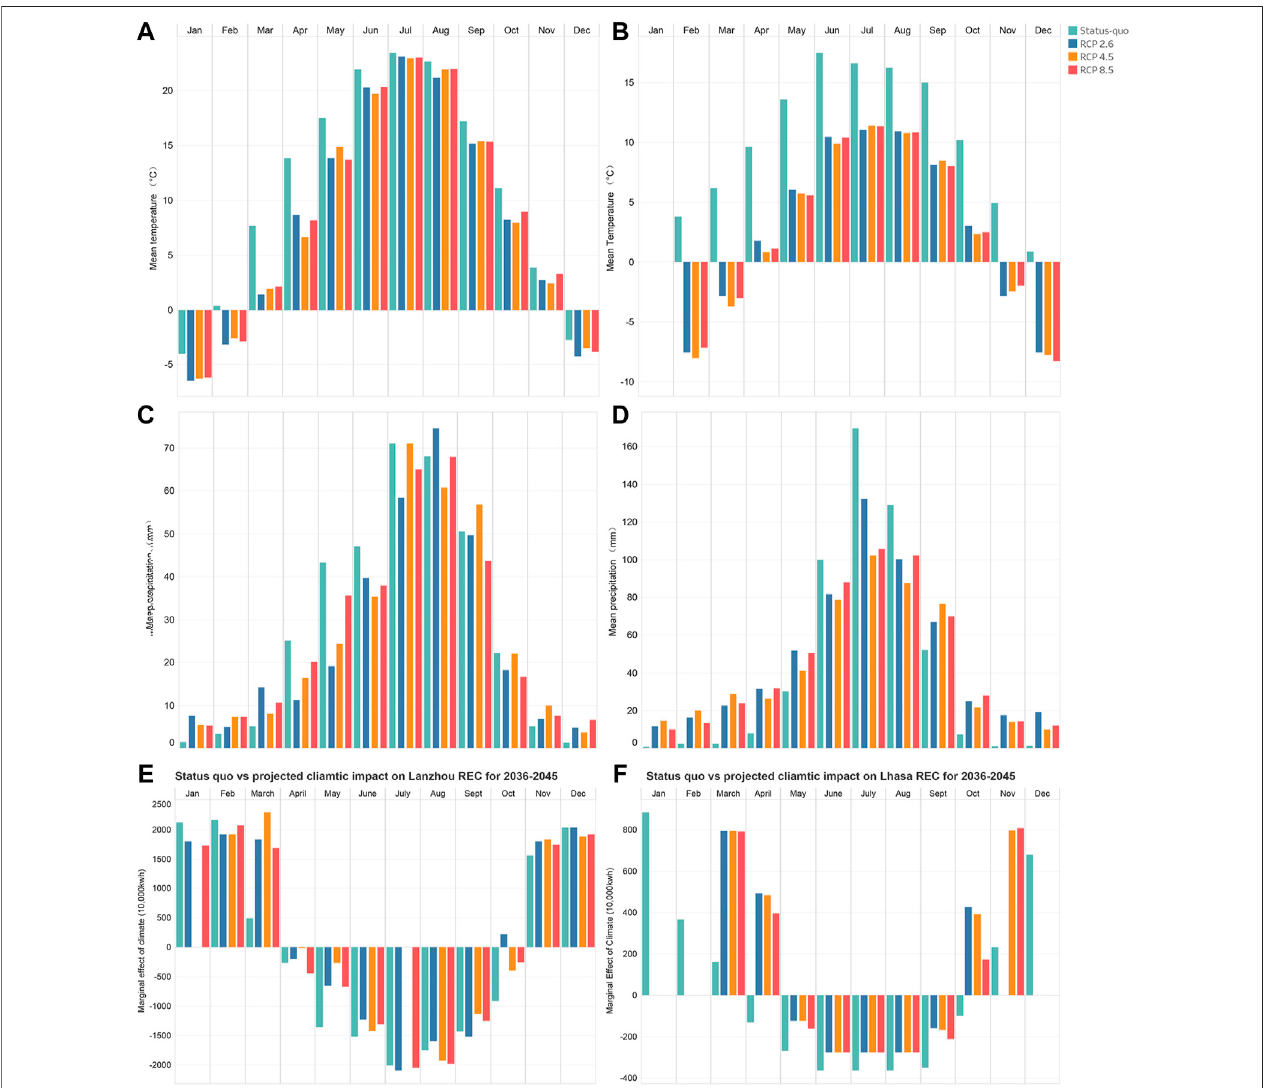
FIGURE7| Projected climatechange and changein climatic impact onresidential electricity consumption (REC) inLanzhou and Lhasa. Comparisons ofobserved and simulatedmonthly meantemperaturesforstatus-quo periods in (A) Lanzhou and (B) Lhasa. Comparison ofobserved and simulated monthlymean precipitation for status-quo periods in (C) Lanzhou and (D) Lhasa. Comparisons between the status-quo climatic impacts on REC with those under the projected climate scenarios during 2036 ‒ 2045 in (E) Lanzhou and (F) Lhasa. Status-quo data are marked in green, RCP 2.6 data in blue, RCP 4.5 data in orange, and RCP 8.5 data in red.